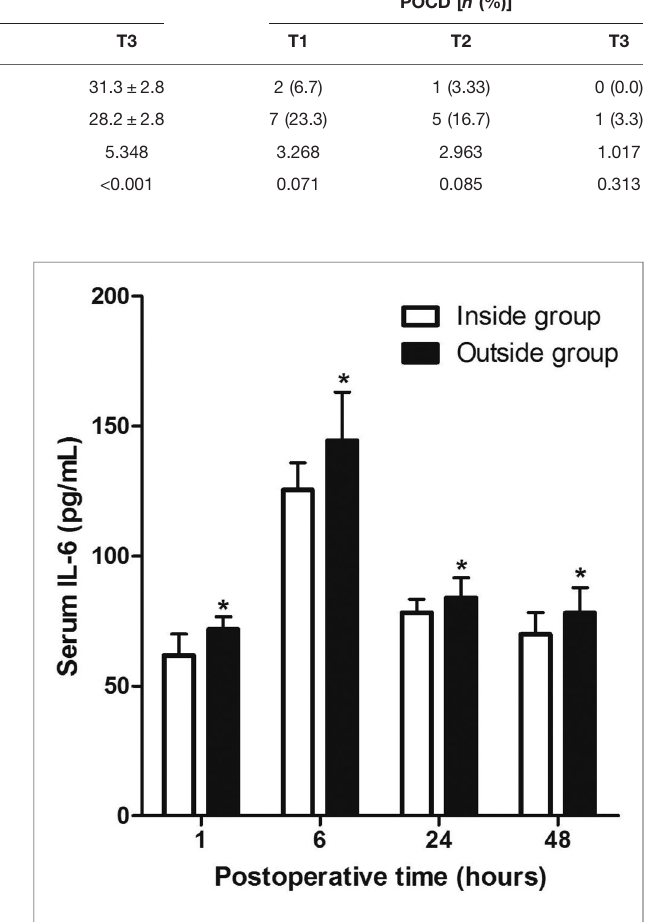
between two groups. Compared with the Inside group, ns p >0.05 and * p <0.05.